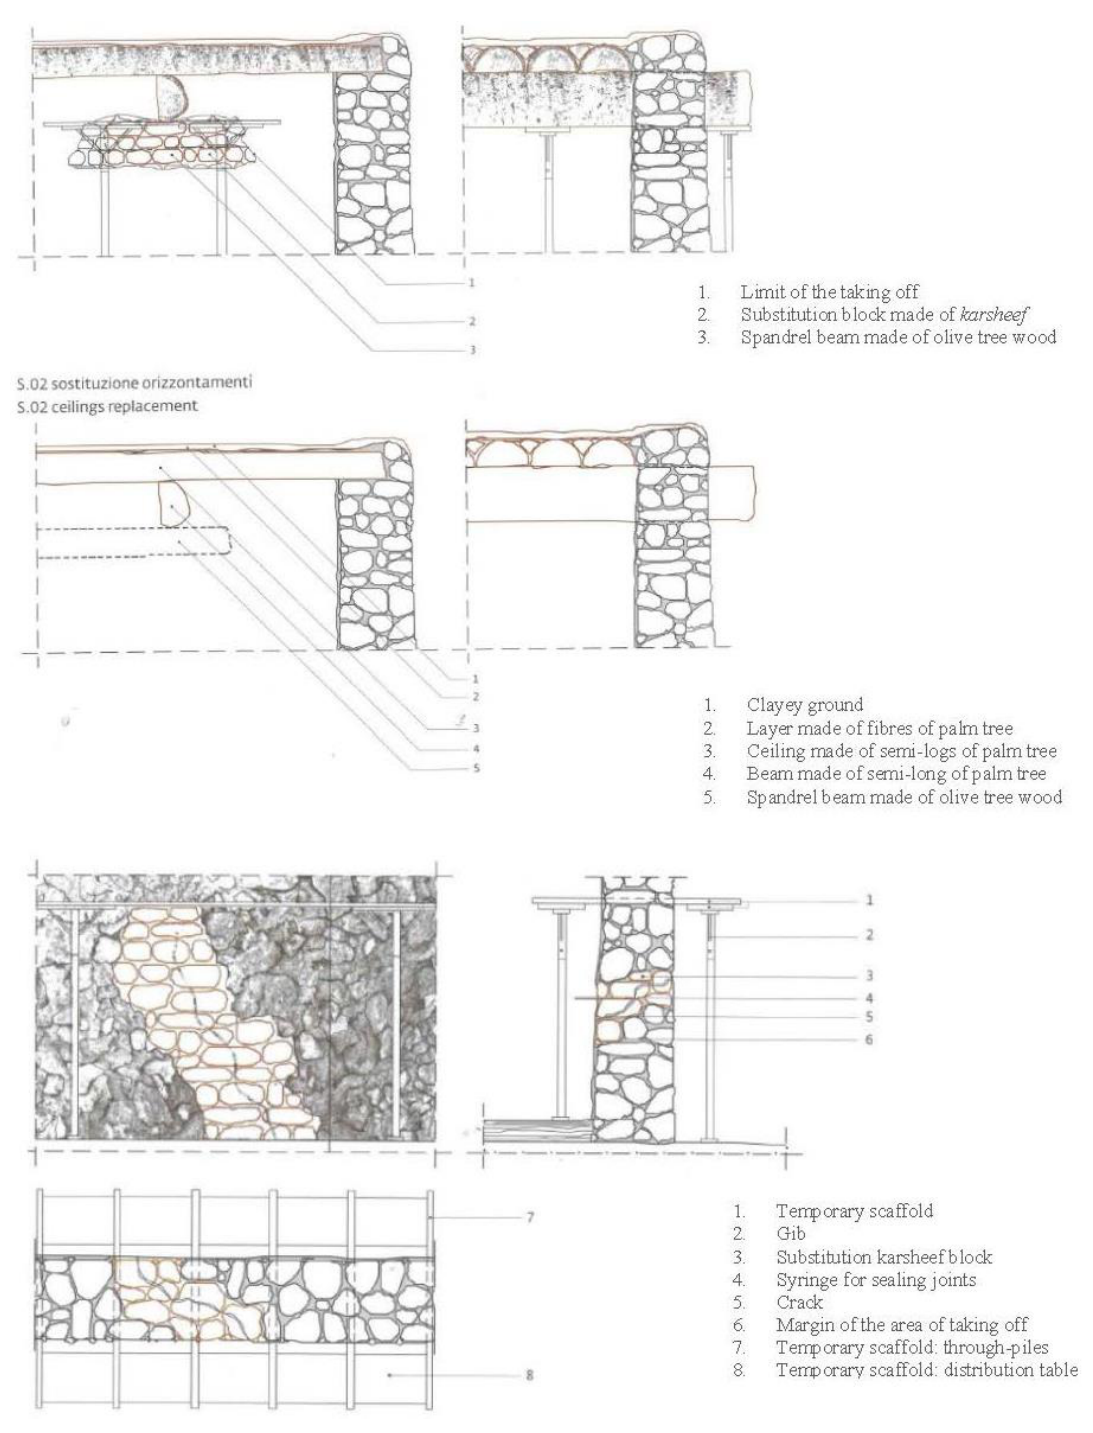
Figure 10. Studies of the construction techniques adopted within the Siwa Oasis (drawings courtesy of the following authors: Calvano S., Loconte P., Pizzolante S., Ricupero P. and Vitulli